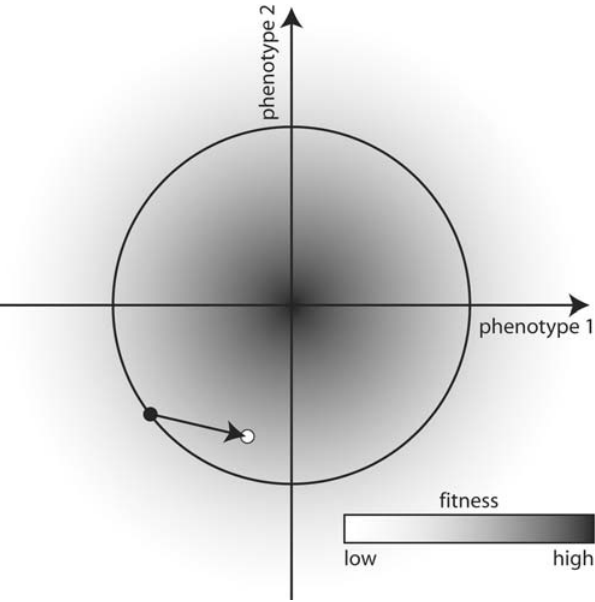
Figure 1. Fisher’s geometric model in two-dimensional phenotypic space. Fitness varies along two phenotypic axes, with the maximum fitness located, for convenience, at the origin of these axes. Any individual in a population (black point) can thus be described by its phenotypic values, which determine the fitness of that organism. At any specific fitness, there are a number of other phenotypic combinations that have equivalent fitness; the values of these phenotypic combina- tions establish the fitness isoclines (black circle). From the optimum, fitness declines monotonically according to the structure of the landscape (see text). Each mutation (arrow) is drawn from a distribution centered on the phenotypic position of each individual, resulting in offspring with new phenotypic combinations and fitness values (white point).